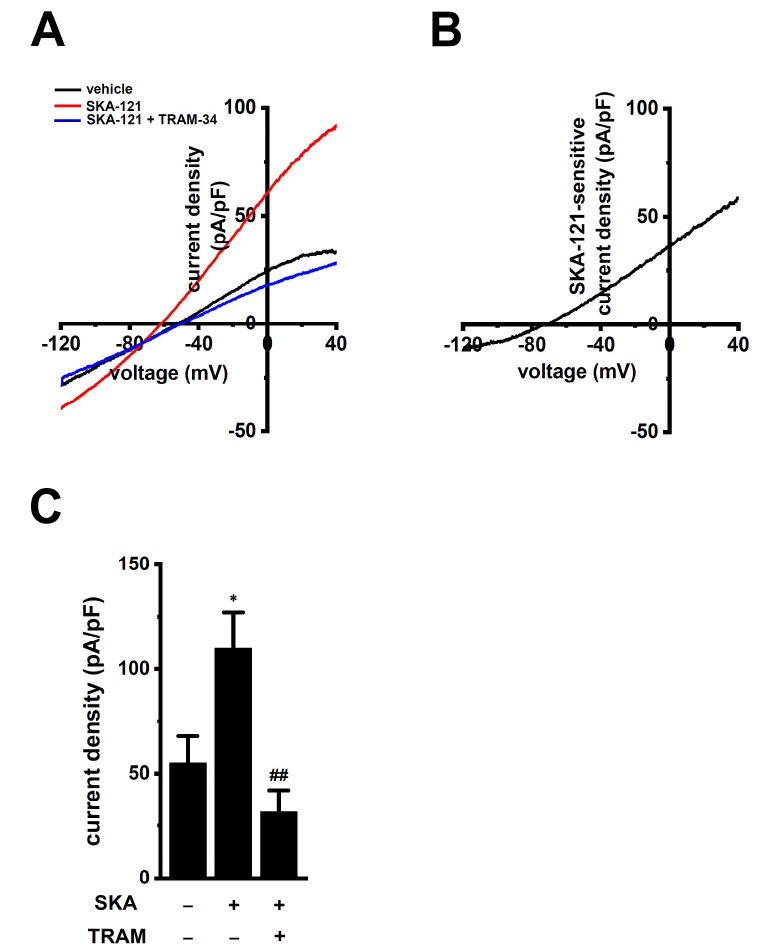
Figure 3. Whole-cell patch-clamp recordings of SKA-121-activated K + currents in THP-1-derived M 2 macrophages. ( A ): Typical current density and voltage-relationships after addition of vehicle (black), 1 μ M SKA-121 (red), and 1 μ M SKA-121 plus 1 μ M TRAM-34 (blue). Currents were elicited by ramp depolarization from −120 to +40 mV from a holding potential of −80 mV every 10 sec. ( B ): Typical current density and voltage-relationship of SKA-121-sensitive component. ( C ): Summarized results of current densities (pA/pF) at +40 mV in three groups (n = 9 for each). *: p < 0.05 vs. vehicle control (−/−); ## p < 0.01 vs. SKA-121 alone (+/−).